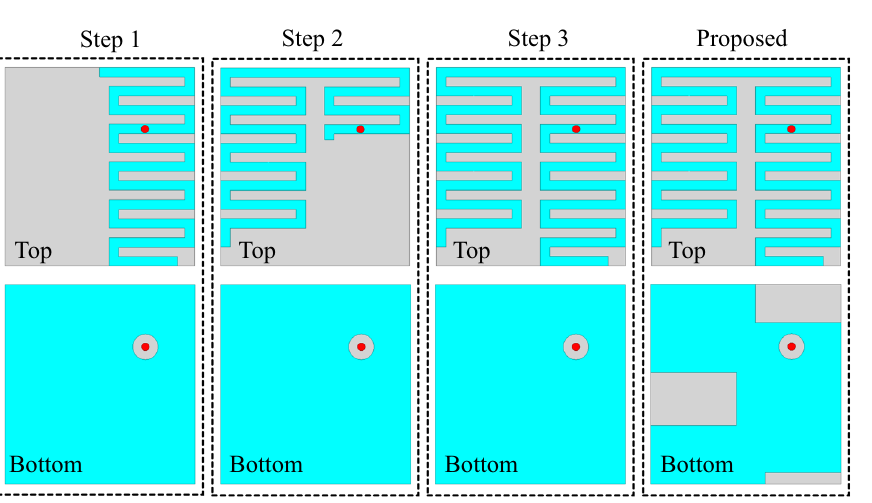
Figure 8. Design iterations of the dual-band implantable